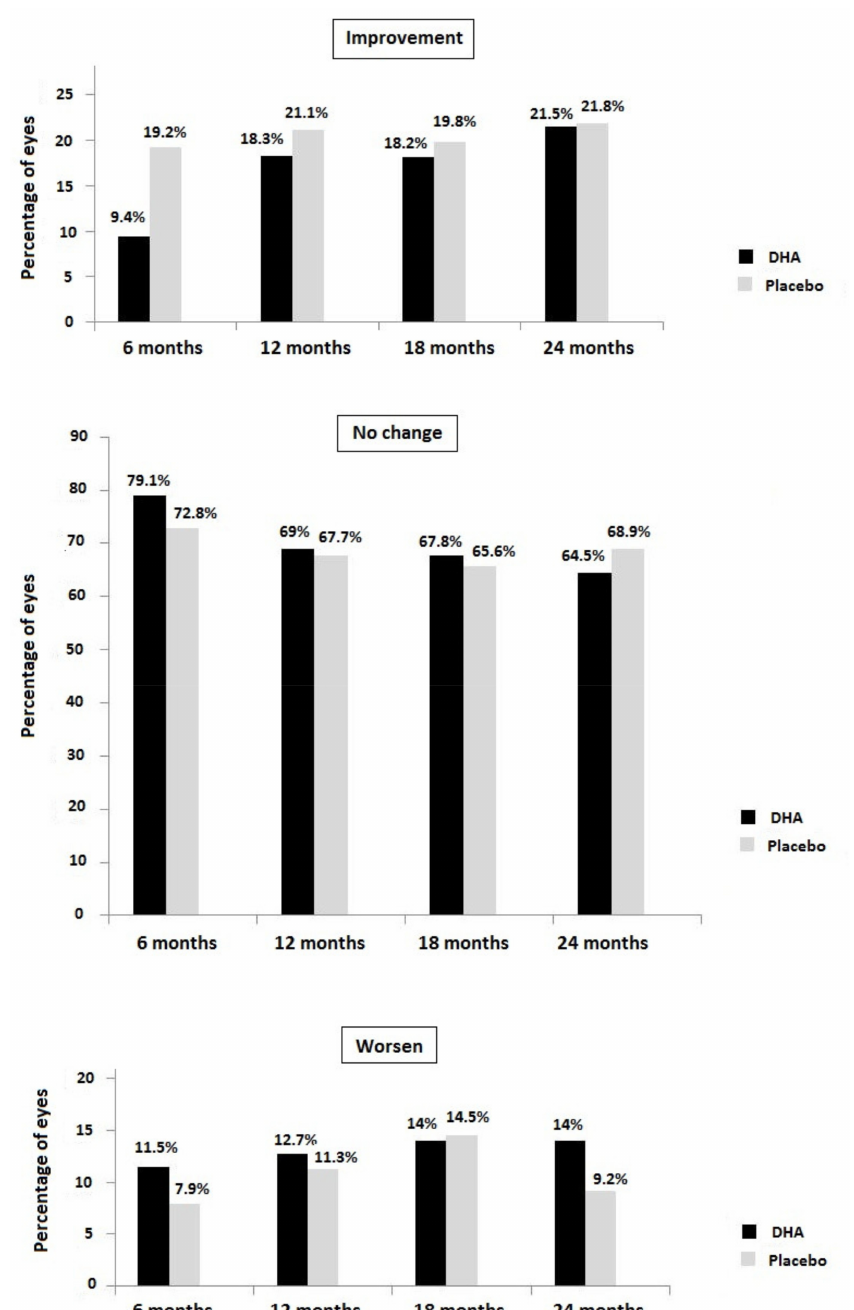
Figure 2. NPDR stage at each study visit in the DHA and placebo groups regarding the percentage of eyes with improvement, no change, or worsening of NPDR